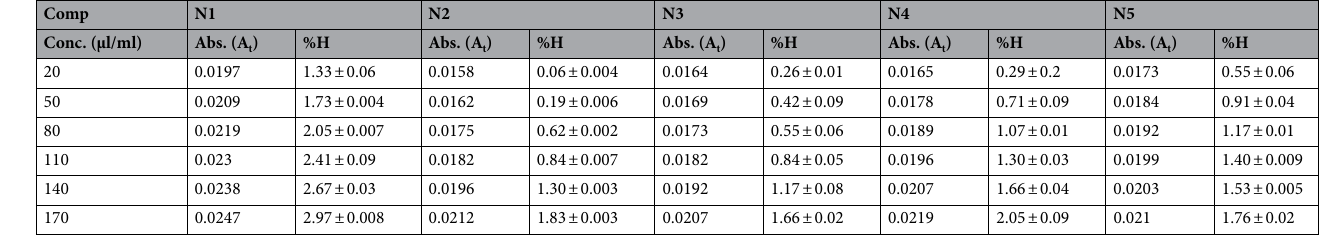
Table 4. Percentages of haemolytic activity of five acrylonitrile adducts. % H = % Haemolysis; Abs. (A